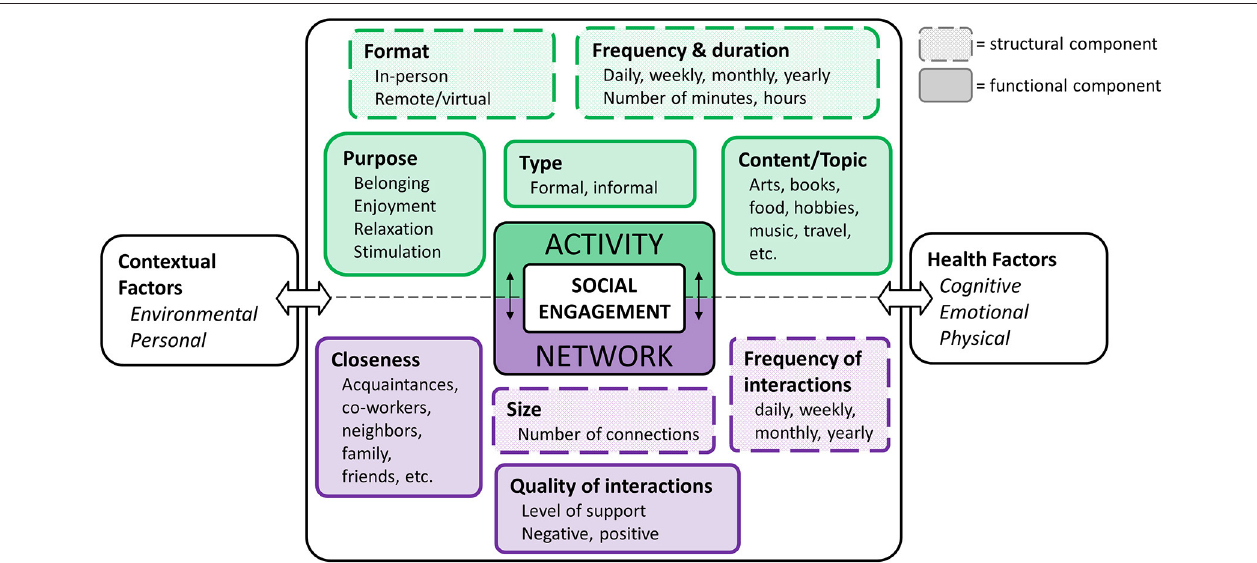
FIGURE 1 | Integrative social engagement